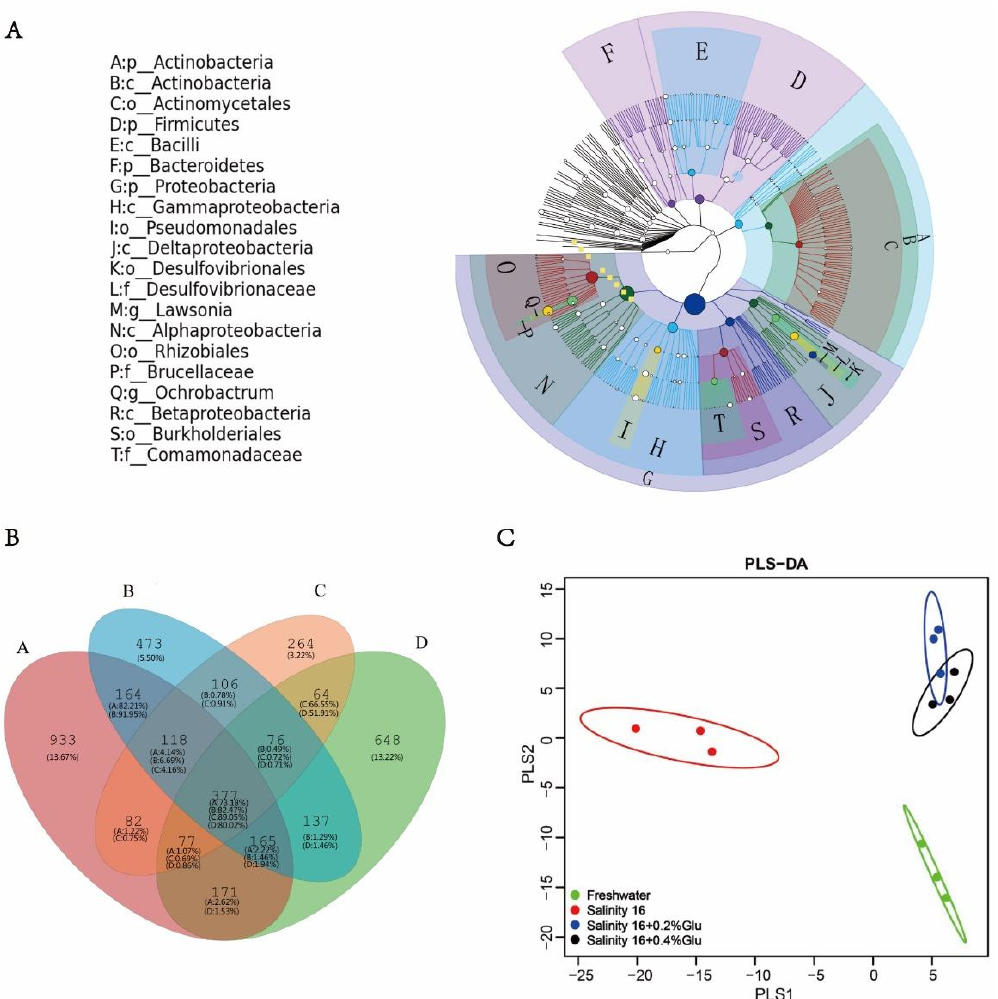
Figure 5. Cladogram (top 20), Venn diagram, and partial least squares discrimination analysis (PLS-DA) diagram of the intestinal microbiota in O. niloticus fed diets with β -glucan in freshwater and brackish water. ( A ) Cladogram of the intestinal microbiota displaying the top 20 components as inferred by GraPhlAn. Node size is proportional to the average abundance. Color indicates the relative concentration of the clusters. ( B ) Venn diagram showing the distribution of all OTUs shared and unique in O. niloticus reared in di ff erent environmental salinity conditions and fed diets with or without β -glucan (0, 0.2%, and 0.4%). The percentage indicates the ratio of correlated OTUs in the total sequences of each treatment. A: 16 psu, B: 16 psu + 0.2% β -glucan, C: 16 psu + 0.4% β -glucan, D: freshwater. ( C ) PLS-DA discriminant analysis of intestinal microorganisms in O. niloticus under di ff erent environmental salinity conditions and fed diets with or without β -glucan (0, 0.2%, and 0.4%). Each dot represents a sample, the points with the same color belong to the same group, and the marked points of groups are marked with ellipses. If the samples belonging to the same treatment are closer to each other, and the distance between the di ff erent treatment points is farther, the classification model will be more reliable.